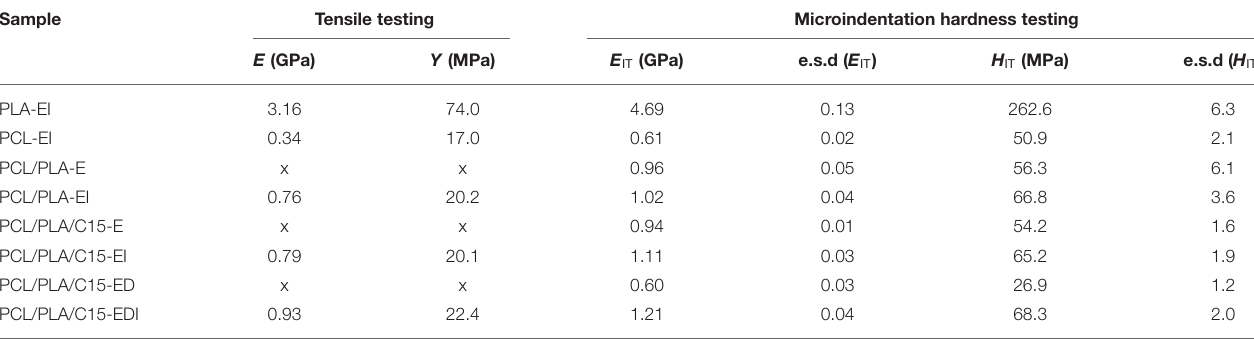
TABLE 3 | Macro- and micromechanical properties.